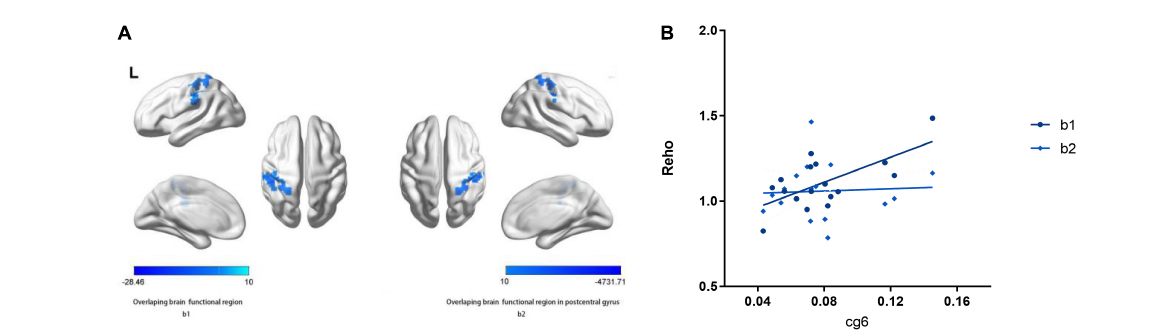
TABLE 3 Significant overlapping clusters that associated with hTERT gene methylation and the degree of social functional impairment in PD.